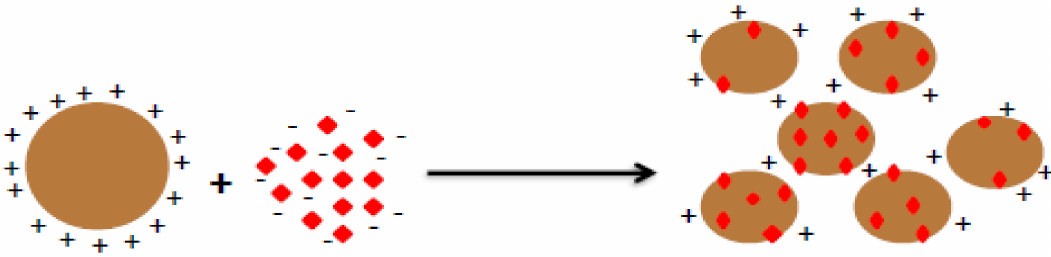
Figure 3. Mechanism of adsorbents in adsorbing